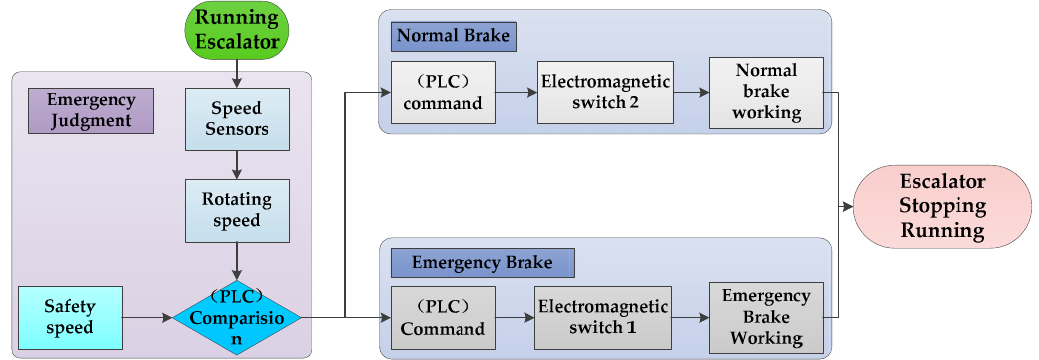
Figure 9. The working principle of the escalator braking system.